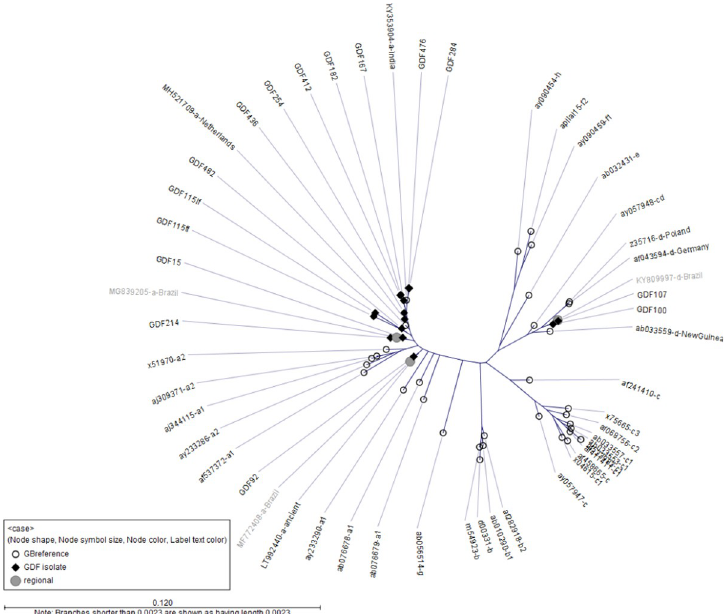
Fig 2. Genetic relatedness of hepatitis B virus cases as demonstrated with phylogenetic maximum likelihood tree constructed using S gene sequences, 2011 Guyana Defense Force Seroprevalence and Behavioral Epidemiology Risk Survey for HIV and sexually transmitted